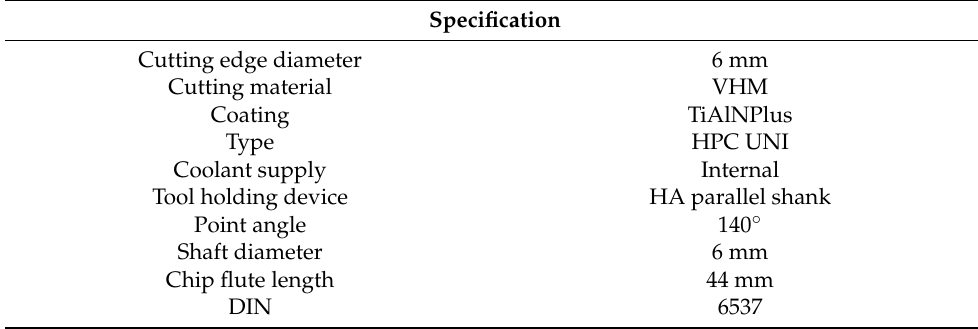
Table 1. Parameters of the drill bit used.